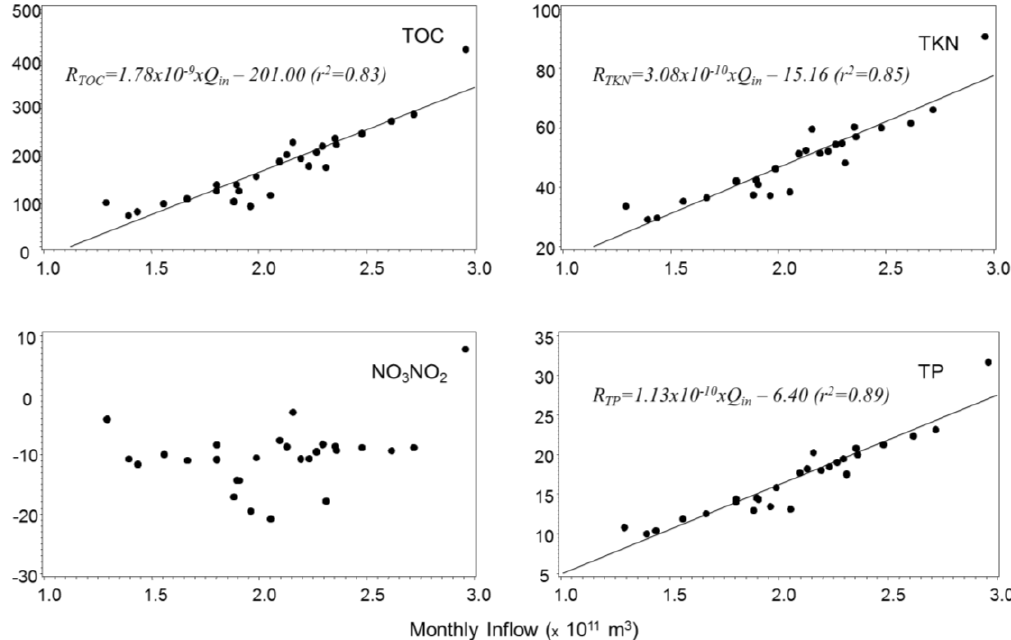
Figure 6. Influence of the river inflow ( Q (TOC), total Kjeldahl nitrogen (TKN), nitrate/nitrite nitrogen (NO phosphorus (TP) in the Atchafalaya